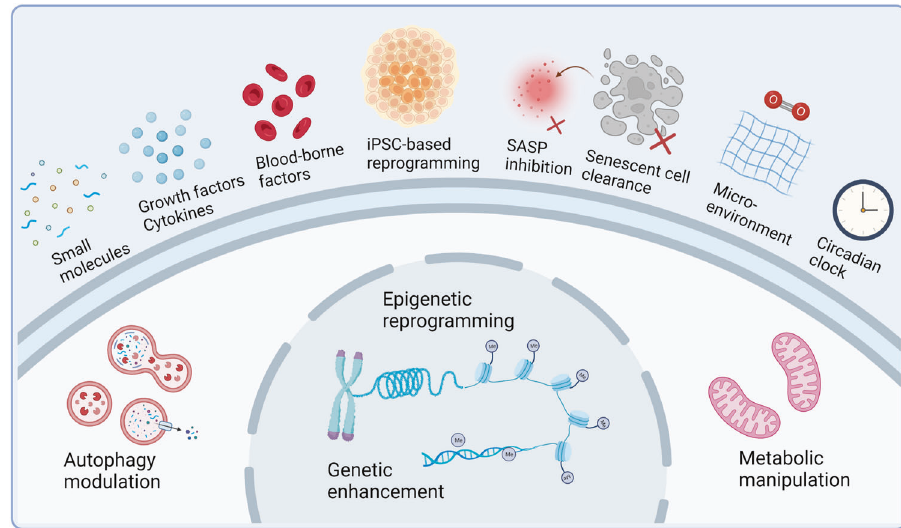
Fig. 4 Schematic overview of strategies for cell rejuvenation. Various strategies have been developed for cell rejuvenation that leverage intrinsic and extrinsic factors, including epigenetic reprogramming, genetic enhancement, autophagy modulation, and metabolic manipulation. Furthermore, small molecules, growth factors and cytokines, blood factors, iPSC technology, clearance of senescent cells and SASP, microenvironment regulation, and circadian clock modulation can also exert great in fl uences on cell rejuvenation. iPSCs induced pluripotent stem cells, SASP senescence-associated secretory phenotype. Created with